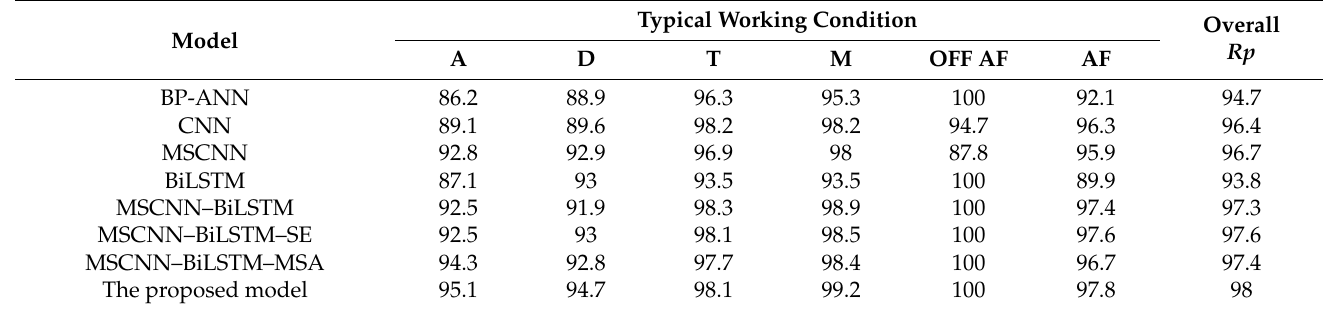
Figure 7. Confusion matrix 2 of working condition recognition. Table 4. The working condition of aeroengine corresponding to the label. label